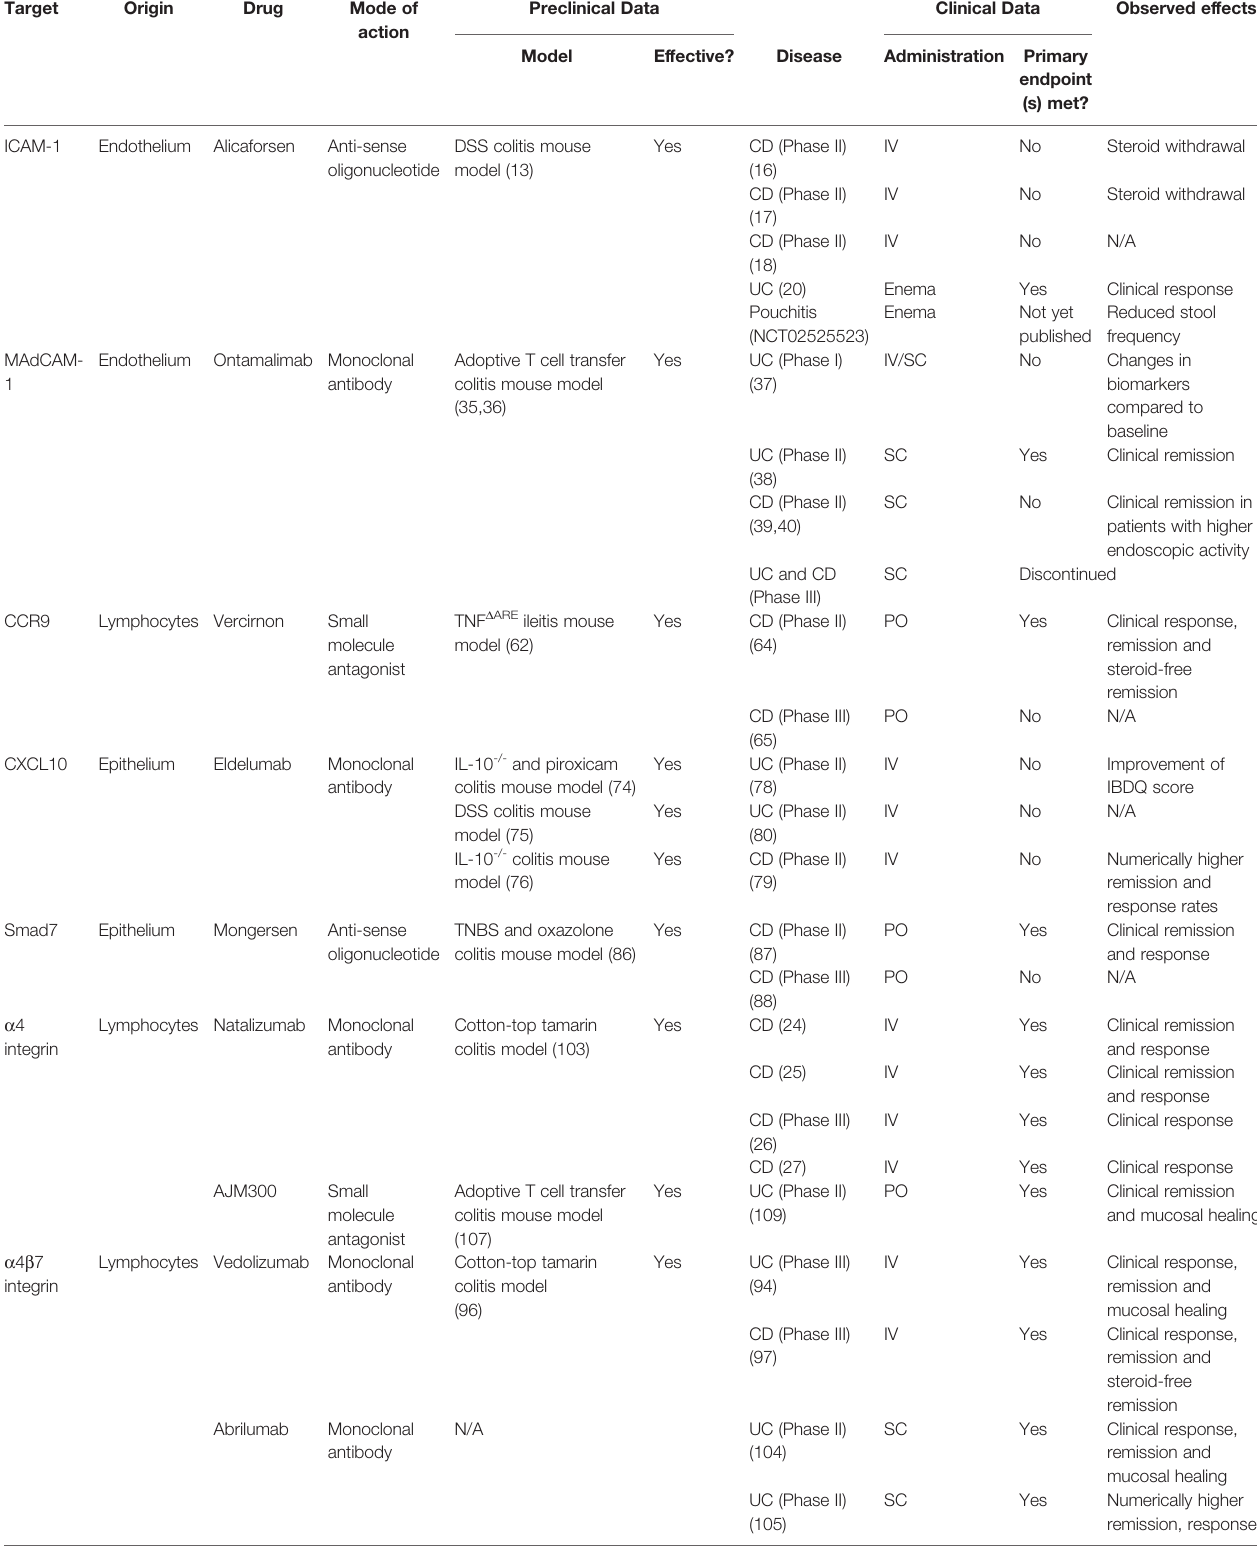
TABLE 1 | Anti-traf fi cking agents used in the clinic or still in development with details on their speci fi c target, mode of action and preclinical and clinical ef fi